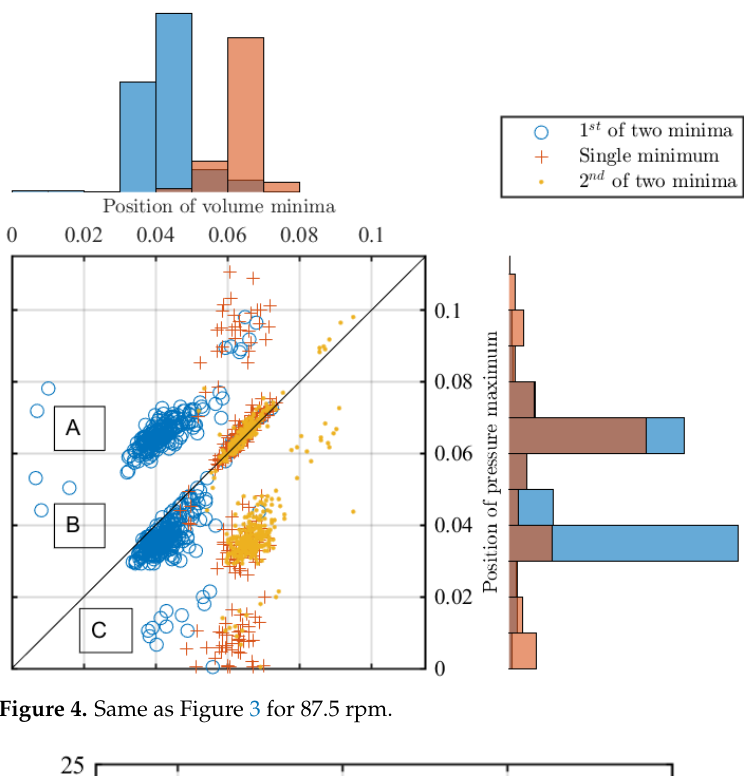
Figure 4. Same as Figure 3 for 87.5 rpm.